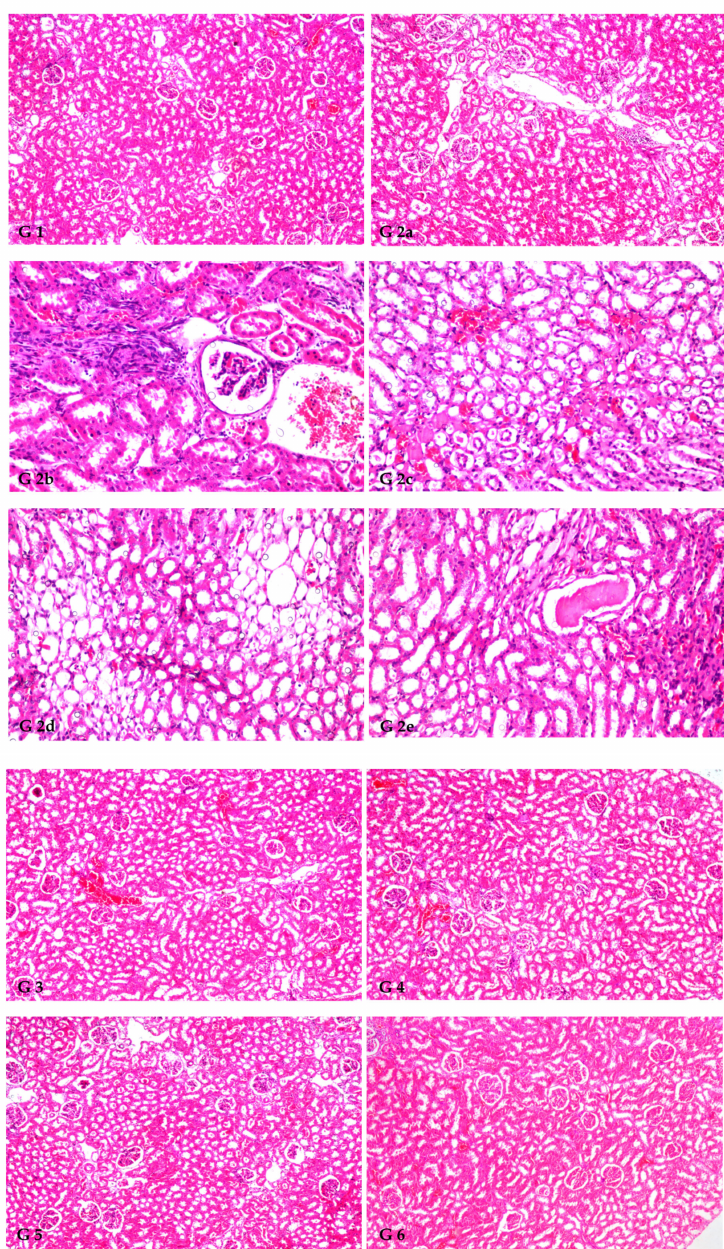
Figure 1. Histopathological findings in rat kidneys treated by FS and FSS extracts along with CCl 4 nephrotoxicity induction (X16 and X40). GI: Show normal histological structure of the glomeruli and tubules at the cortex, as recorded ( G1 ). The histoarchitecture of the CCl 4 -treated rats (G2) showed focal inflammatory cell infiltration at the cortex surrounding the glomeruli and blood vessels as well as between the tubules ( G2a ), focal fibrosis with atrophy and obliteration of the tubules with dilatation of the blood vessels at the cortex ( G2b ), corticomedullary portion showed focal hemorrhages between the obliterated tubules ( G2c ), focal cystic dilatation with flattened lining epithelium in others ( G2d ), and eosinophilic casts formation was detected in the lumen of the cystic tubules at the corticomedullary adjacent to the focal fibrosis ( G2e ). G3 (300 mg kg − 1 aqueous extract of FS) shows congestion in the cortical blood vessels ( G3 ). In ( G4 ) (600 mg kg − 1 FS of aqueous extract), (G5, 300 mg kg − 1 of FSS alcoholic extract), and ( G6 , 600 mg kg − 1 of FSS alcoholic extract) showed no histopathological alteration as recorded in ( G4 , G5 , and G6 ),